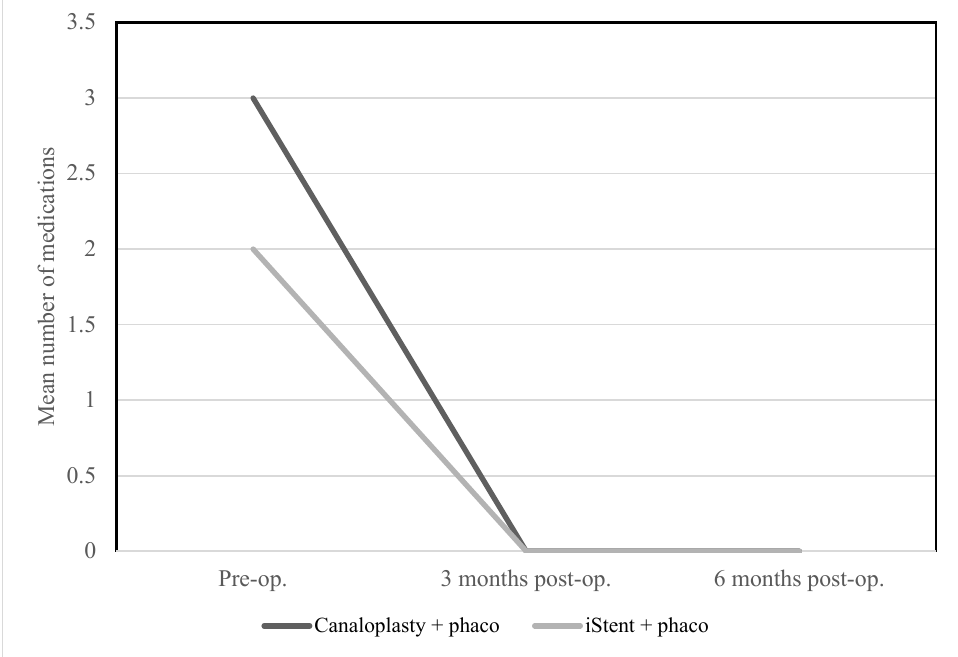
Figure 2. Mean number of medications from baseline to 6 months post-surgery according to type of surgery.